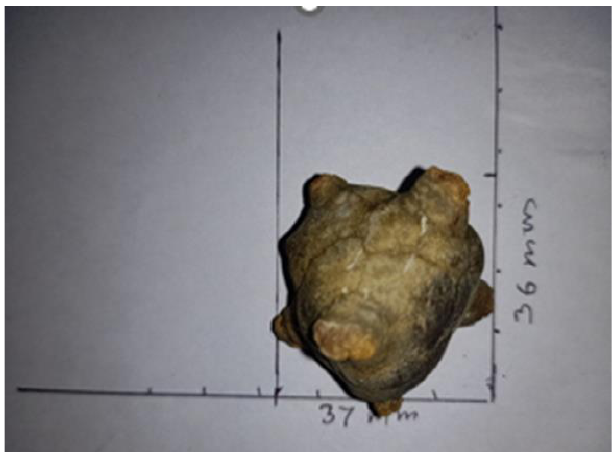
Figure 5. Bladder stones. Reprinted from ref. [32], under creative common license (CC BY-SA 4.0), Originally created by Vijayanrajapuram.